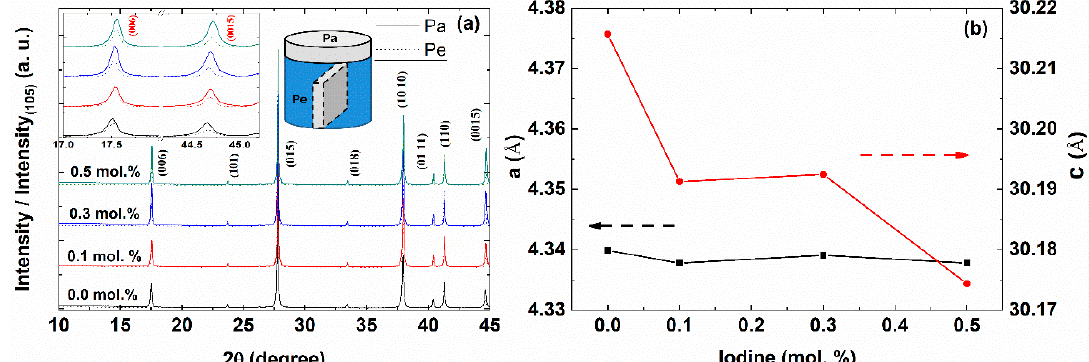
Figure 1. X-ray diffraction (XRD) peaks for the parallel (Pa, solid line) and perpendicular (Pe, dotted line) directions to the press direction ( a ) and the lattice parameters of the a -axis (black square, left axis) and c -axis (red circle, right axis) ( b ) of the Bi 2 Te 2.85 Se 0.15 I x (x = 0.0, 0.1, 0.3, and 0.5 mol.%) compounds. The right upper inset shows the intensity ratio of the (00 l ) peaks.